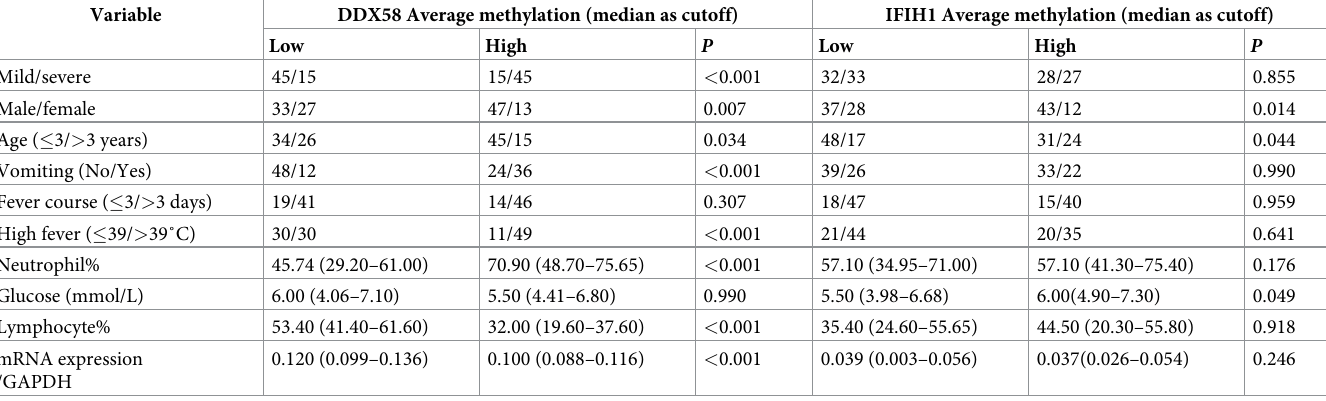
Table 3. The relationship between the DDX58/IFIH1 methylation levels and clinicopathological factors in EV71-HFMD.